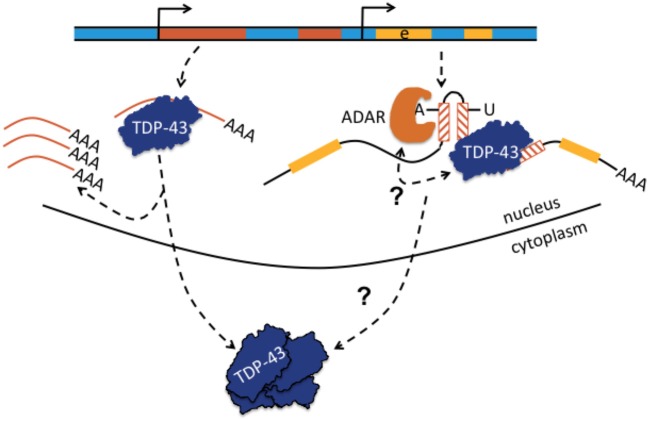
Transactive response DNA-binding protein (TDP-43 or TARDBP) may bind to single-stranded retrotransposons or to retrotransposons embedded in pre-mRNA and may regulate TE abundance or affect A-to-I editing. Normally, TDP-43 is proposed to act as a scavenger of TE-derived transcripts and regulates TE abundance. When TDP-43 function becomes comprised, as in certain neurodegenerative diseases with depletion of TDP-43 from the nucleus and aggreation in the neuronal cytoplasm, TEs become overexpressed (shown left-hand; Krug et al., 2017). Depicted right-hand, TDP-43 can also bind to retrotransposons contained in pre-mRNA and it was proposed that TDP-43 limits the extent of ADAR-mediated A-to-I editing in intronic inverted repeat dsRNA structures. A-to-I editing increases if nuclear TDP-43 is depleted. The bidirectional arrow questions whether the interaction is reciprocal and whether altered A-to-I editing may also lead to compromised binding of TDP-43 to pre-mRNA with loss of nuclear TDP-43 predominance, translocation to the cytoplasm, and aggregation. Yellow parts represent exons (e).